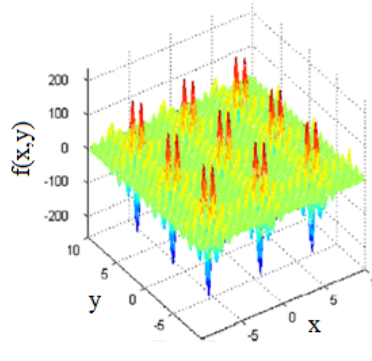
Figure 9: Himmelblau’s